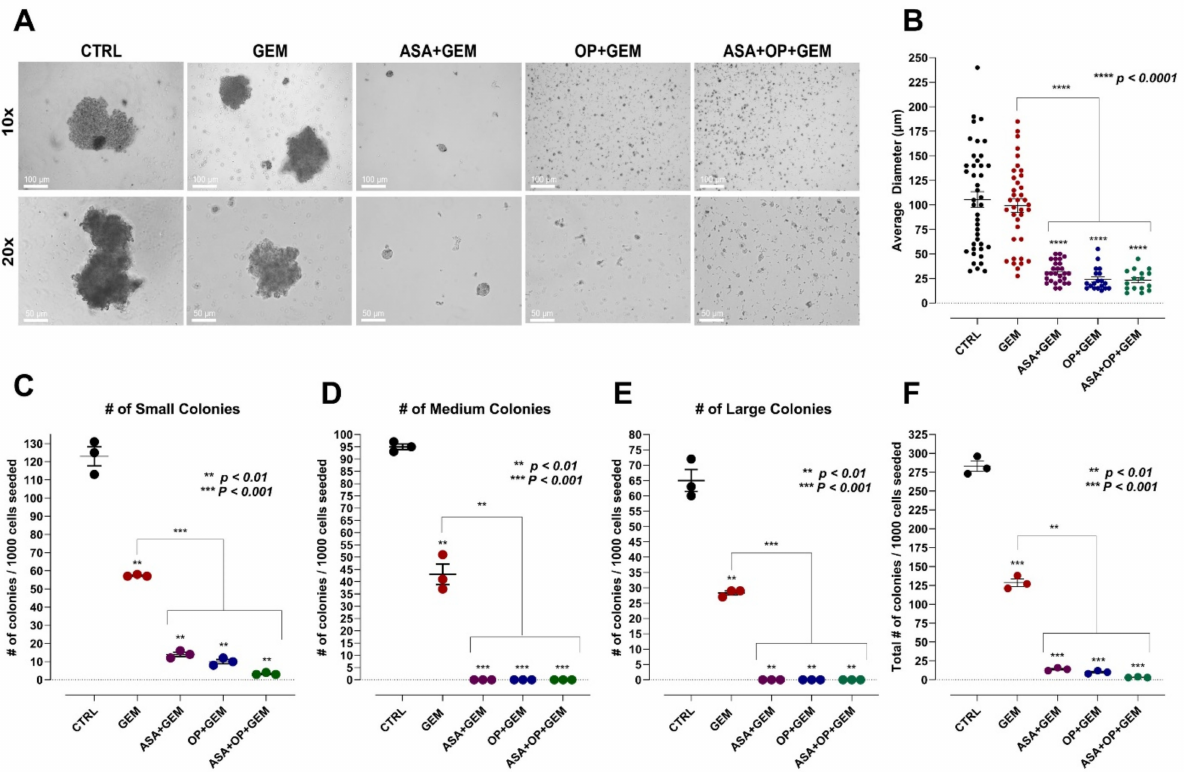
Figure 4. ASA, OP, GEM, and their combination reduce the clonogenic potential of MiaPaCa-2 pancreatic cancer cells. MiaPaCa-2 cells were treated with ASA (0.7 mM), OP (3.5 mM), GEM (0.285 µ M), or their combination for 7 days. Cells were counted and resuspended in methylcellulose- containing media at a density of 3000 cells/mL. Cells were plated in 35-mm tissue culture dishes and incubated for 14 days. ( A ) Images were obtained after 14 days using phase microscopy, with the 10 × and 20 × objective. ( B ) The diameter of colonies was measured using a graded dish on a phase-contrast microscope. The number of ( C ) small colonies (<50 µ m), ( D ) medium colonies (>50 µ m;<100 µ m), and ( E ) large colonies (>100 µ m) was plotted. ( F ) The degree of clonogenicity was determined as the total number of colonies per dish in triplicates. The number of colonies formed from the treatments was compared to the CTRL and GEM-treated groups using the one-way ANOVA Fisher test comparisons with 95% confidence, indicating asterisks for statistical significance. Data are presented as the mean ± SEM of 3 independent experiments performed in triplicates. Abbreviations: ASA, aspirin; OP, oseltamivir phosphate; GEM, gemcitabine; CTRL, control; SEM, standard error of the